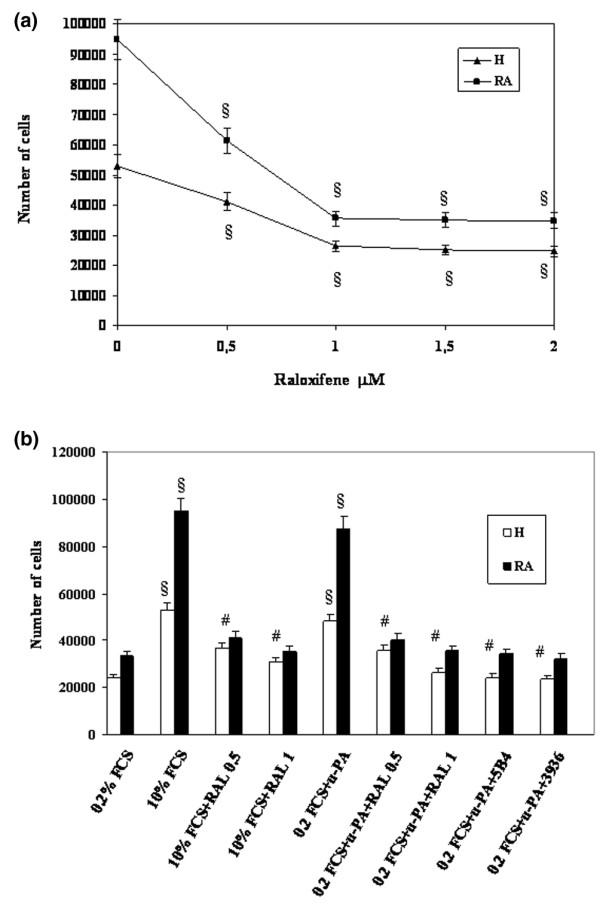
Effects of Raloxifene (RAL) on proliferation in healthy (H) and rheumatoid arthritis (RA) synoviocytes. (a) Proliferation of H and RA synoviocytes as a function of RAL concentration. Synoviocytes were seeded in 24 multi-well plates (15,000 cells/well) with 10% FCS in RPMI 1640. After 24 h incubation, cells were treated with increasing concentrations of RAL (0.5 to 2 μM). (b) Proliferation of H and RA synoviocytes under control conditions (0.2% FCS as a negative control, and 10% FCS as a positive control), in 0.2% FCS under the effect of 500 ng/ml urokinase-type plasminogen activator (u-PA) and in the presence of 0.5 and 1 μM RAL or the monoclonal antibodies (mAbs) 5B4 and 3936, which impair u-PA/u-PAR binding (see text for details). In both (a) and (b), each point represents the mean ± standard deviation of three experiments performed in triplicate on four normal and four RA synovial cell lines. § = p < 0.01 versus basal (0.2% FCS); # = p < 0.001 versus 10% FCS or u-PA, for both H and RA.